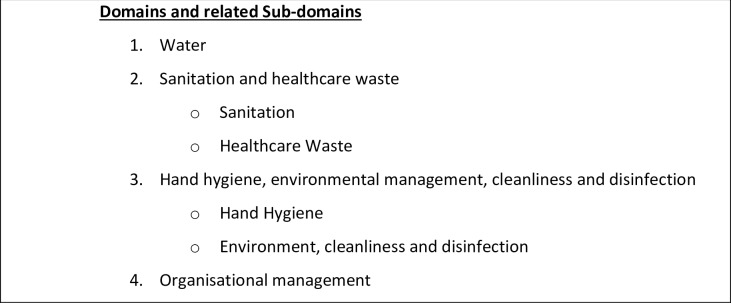
Domains assessed in WASH FIT[8].